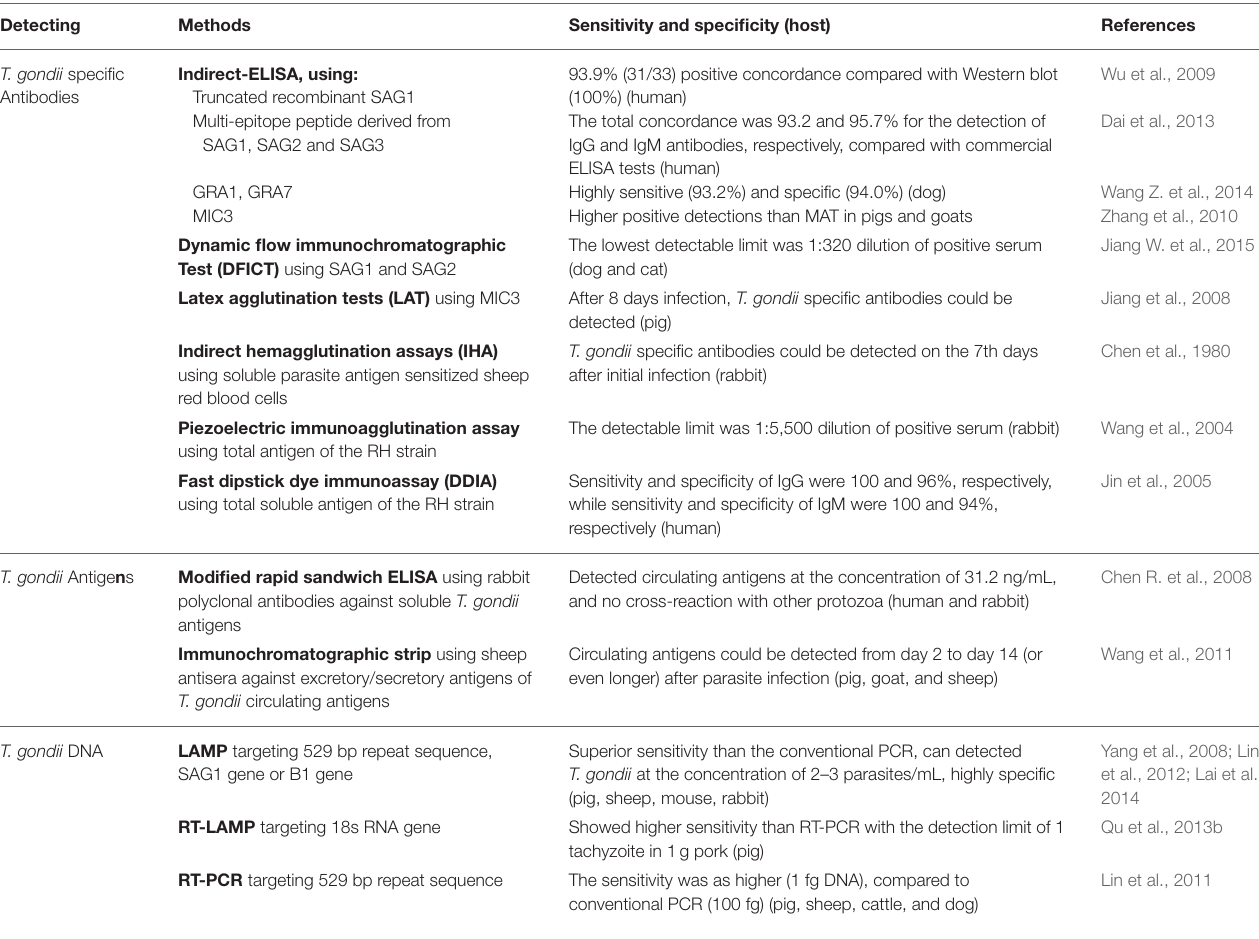
TABLE 1 | Diagnostic methods developed by scientists in